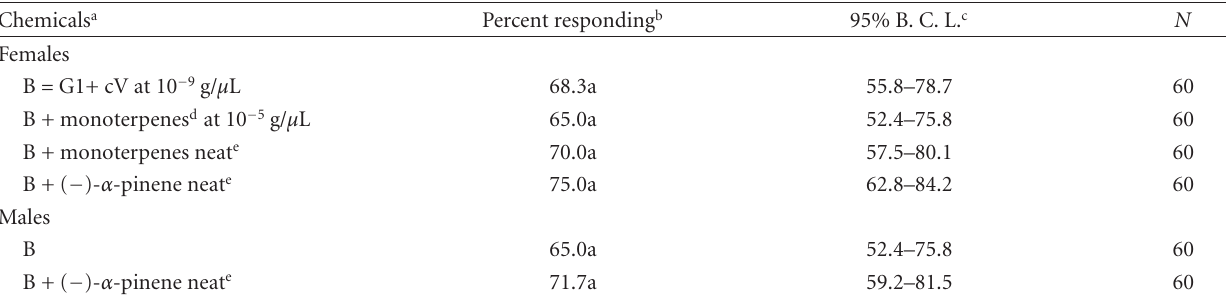
Table 2: Percent of walking Pityogenes bidentatus females and males responding in a laboratory olfactometer (7 June 1999) to conifer monoterpenes and aggregation pheromone components (G1 = grandisol, cV = ( S )- cis